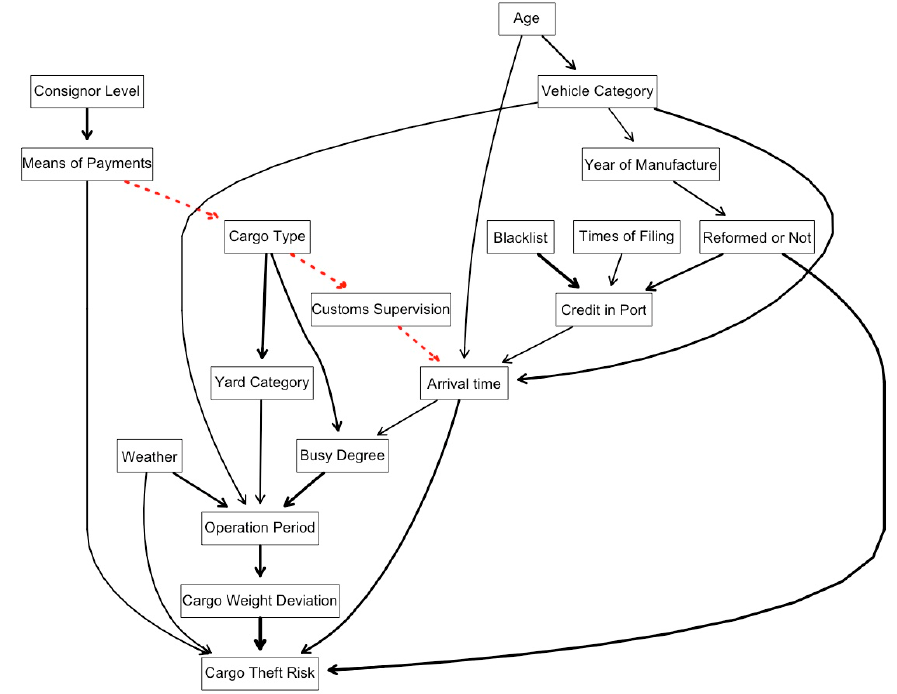
Figure A3. The Bayesian network structure derived using combinations of heuristic structure search algorithm with HC and score function with BDe .